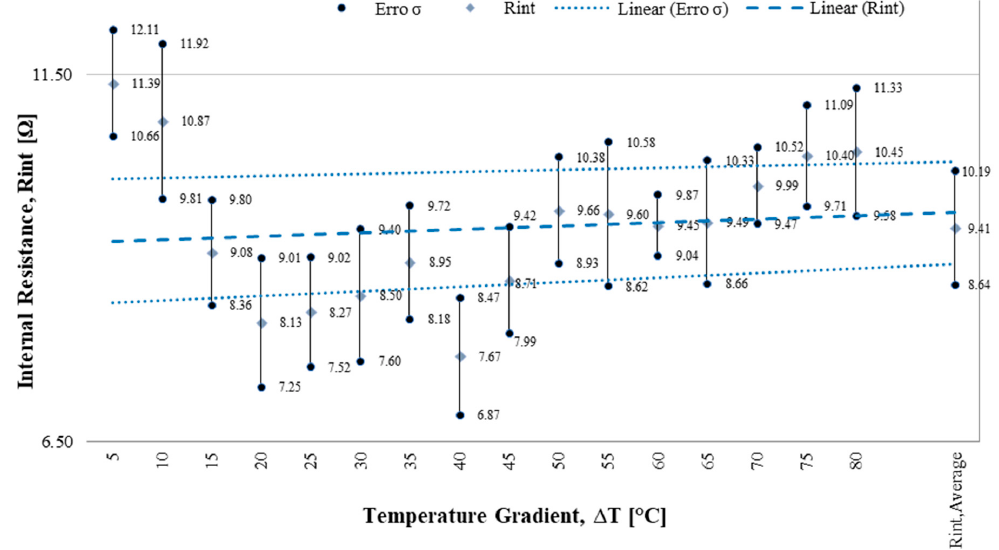
Figure 5. Internal resistance means (R int ) for different temperature gradients ( Δ T) and their respective standard deviations ( σ n ).